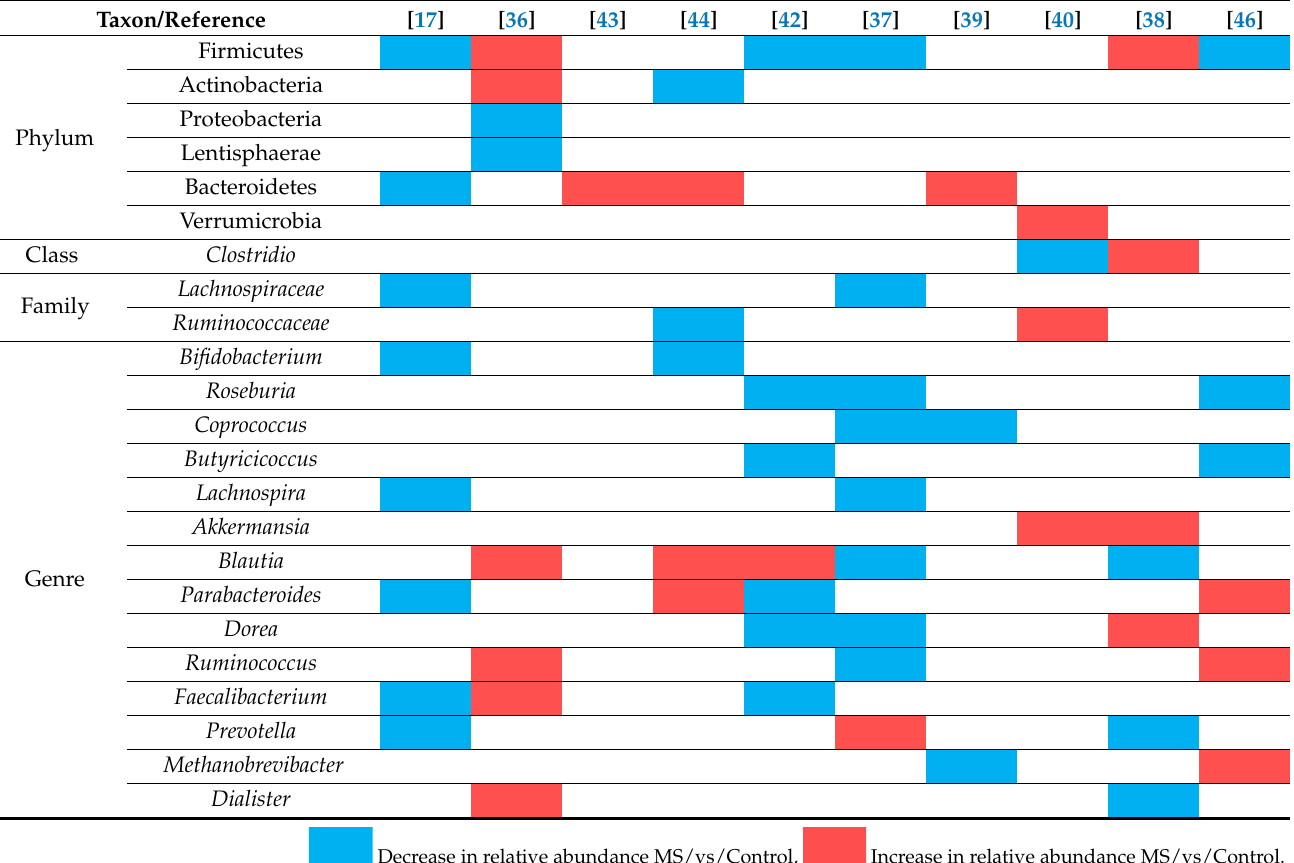
Table 4. Clue findings of relative abundances regarding taxon levels: MS vs. control group cases.